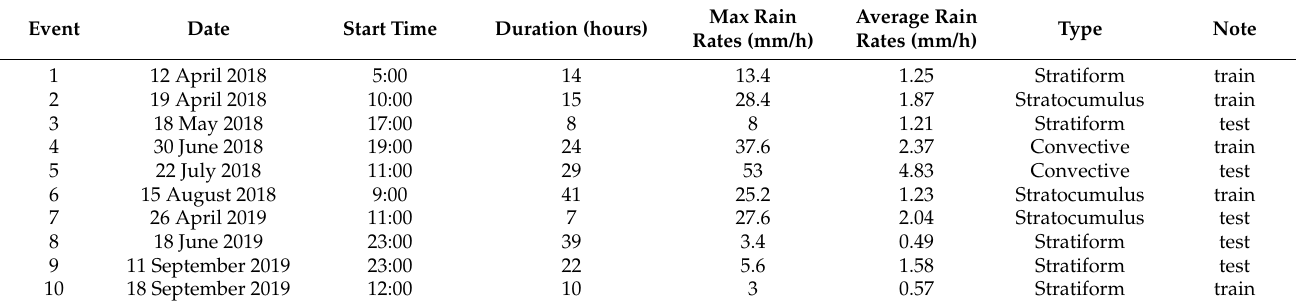
Table 1. Details of 10 rainfall